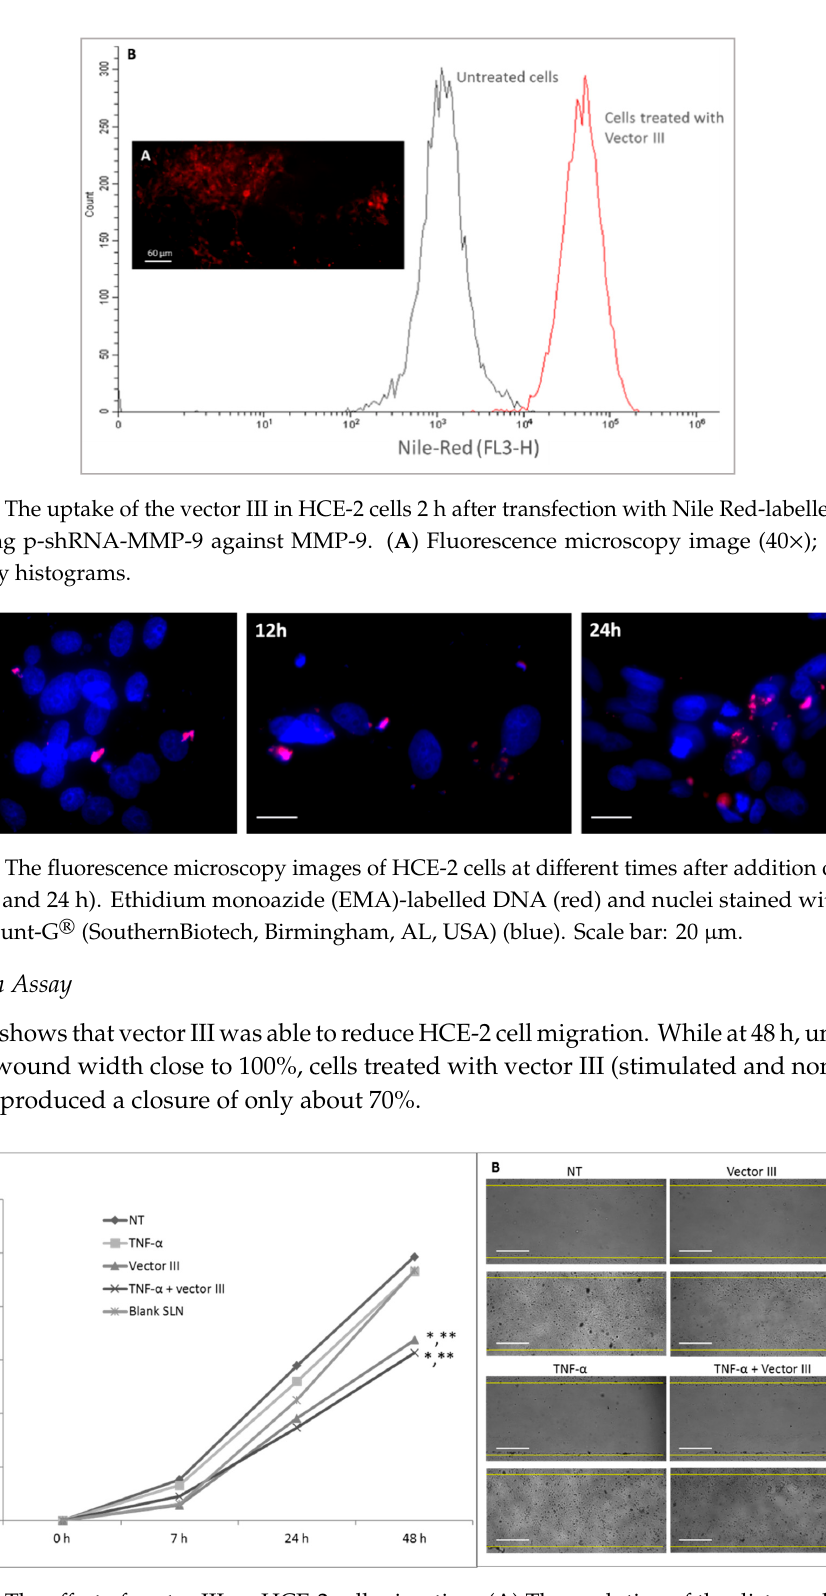
Figure 8. The effect of vector III on HCE-2 cell migration. ( A ) The evolution of the distance between cells of the edge of the wound; the mean data of reduction of the wound width from the 4 replicates (measures) in each condition. ( B ) Phase contrast representative images (4×). NT: non-treated cells. Statistics at 48 h. * p < 0.05 respect to NT, ** p < 0.05 respect to cells treated with TNF- α . Scale bar: 60 µ